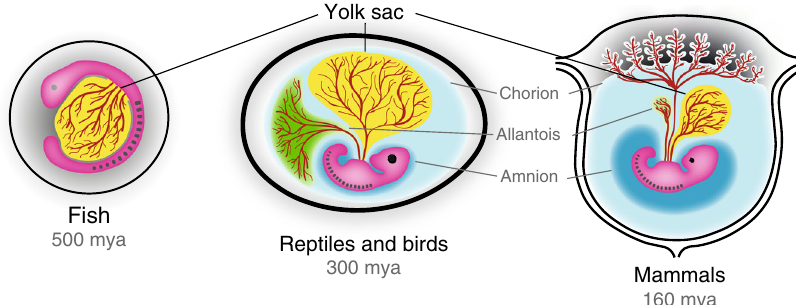
Fig. 1 Extraembryonic membranes in fi sh, birds and mammals. The yolk sac dates back to our aquatic ancestors and thus represents the phylogenetically oldest extraembryonic tissue. Amnion, chorion and allantois are inventions of the amniotic egg, which have been subsequently adapted in mammals to support embryonic development inside the uterus. mya million